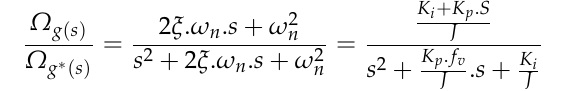
Figure 3. MPPT Strategy.